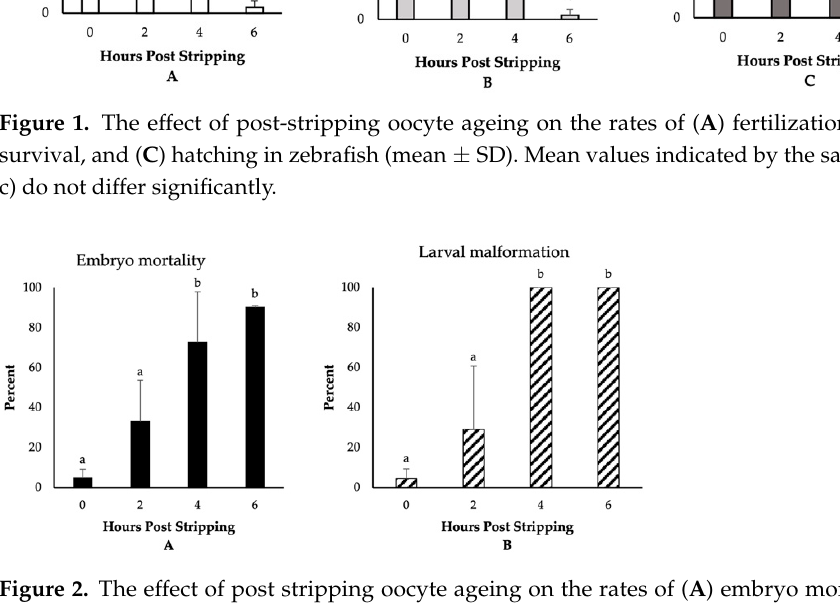
Figure 2. The effect of post stripping oocyte ageing on the rates of ( A ) embryo mortality and ( B ) larval malformation in zebrafish (mean ± SD). Mean values indicated by the same letter (a, b) do not differ significantly.